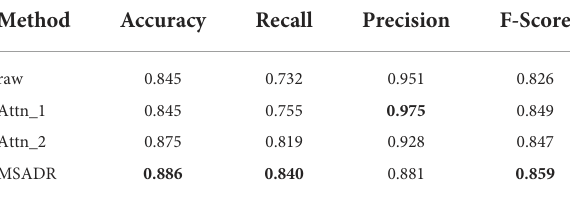
TABLE 4 Detection comparison of ablated models trained using leave-one-out cross-validation on the entire dataset. Method Accuracy Recall Precision F-Score